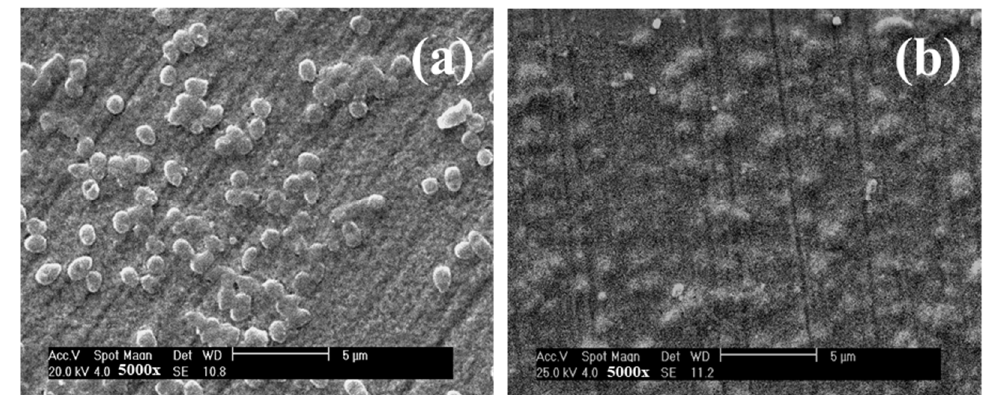
Figure 4. SEM images indicating the bacterial cell attachment in pure TaN coating ( a ), and TaN/Cu coating with a Cu content of 30.04 at.% ( b ).